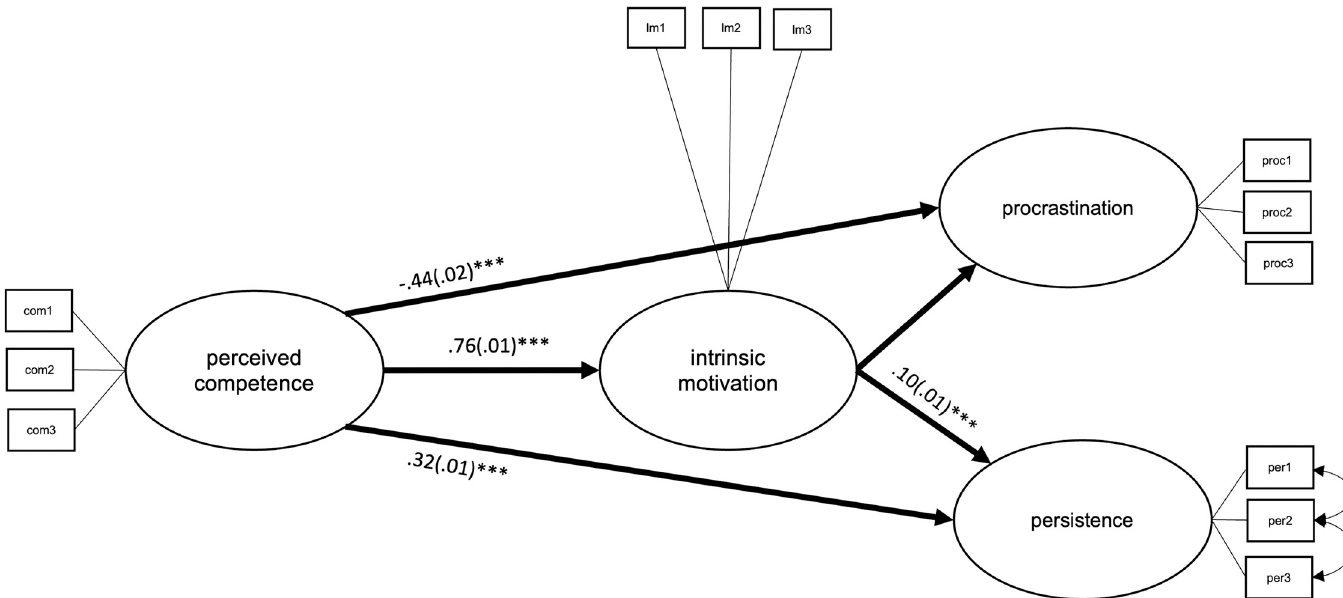
Fig 8. Latent structural path model of the direct effects between perceived competence, intrinsic motivation, procrastination, and persistence, with average coefficients across all countries. ��� p = < .001.